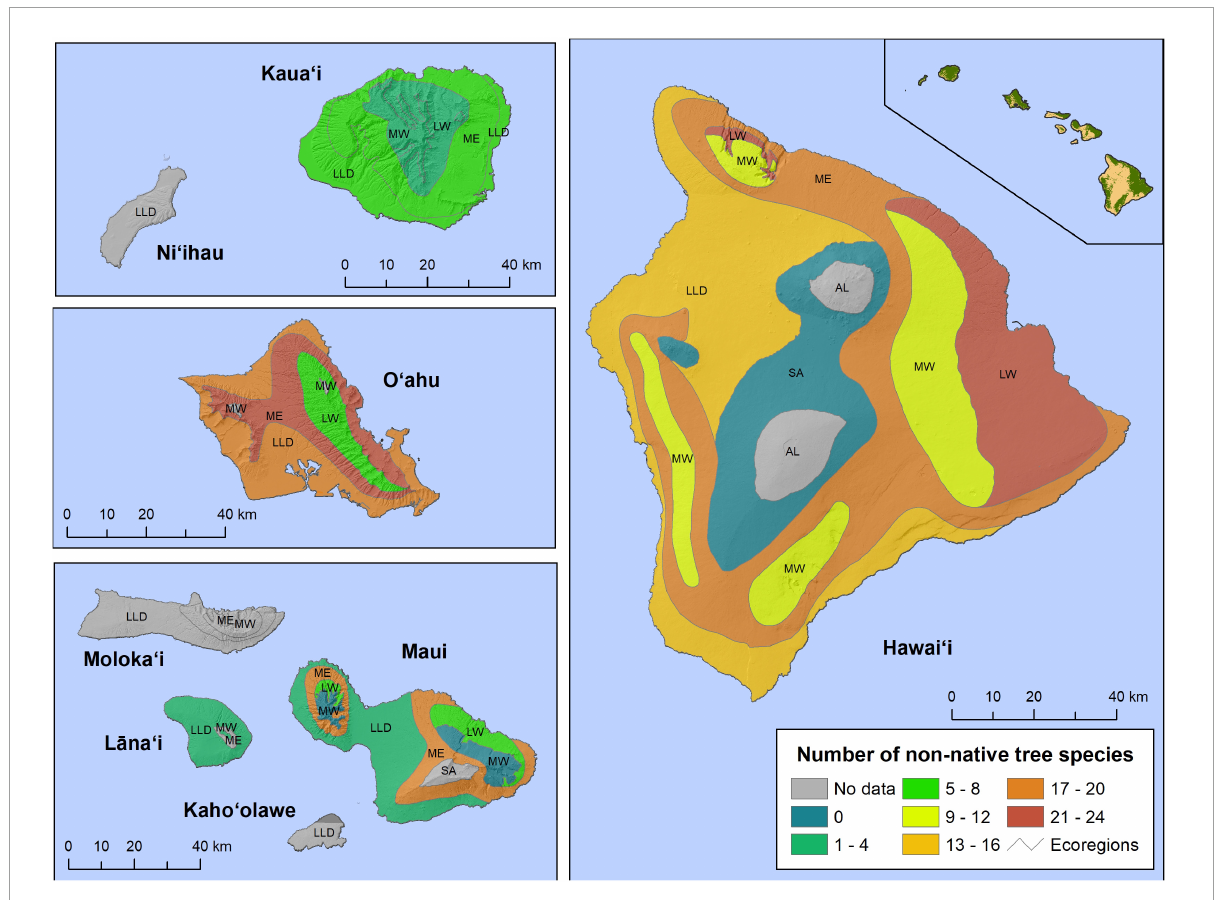
FIGURE4 The number of non-native tree species present in each Hawaiian ecoregion, by island, using Forest Inventory and Analysis (FIA) tree occurrence data. (Note the binning of species richness differs from Figure 2 ). AL, alpine; LLD, lowland/leeward dry; LW, lowland wet; ME, mesic; MW, montane wet; SA,